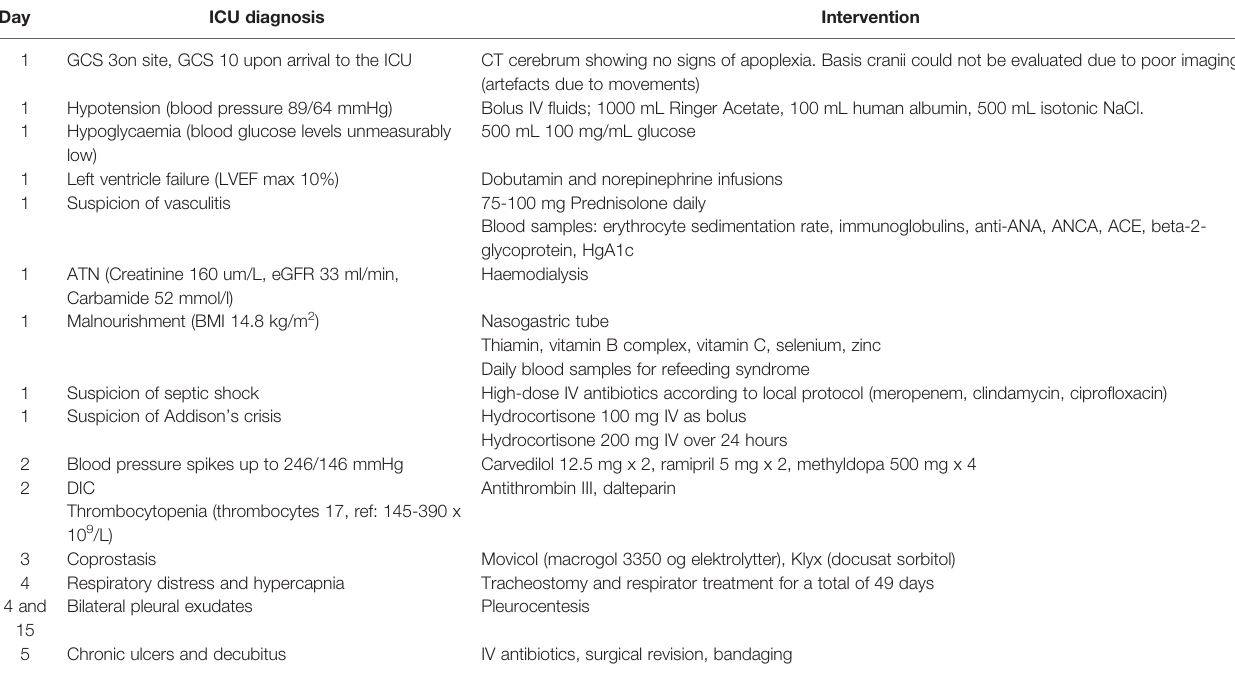
TABLE 1 | Initial life-saving treatments for multi-organ failure.